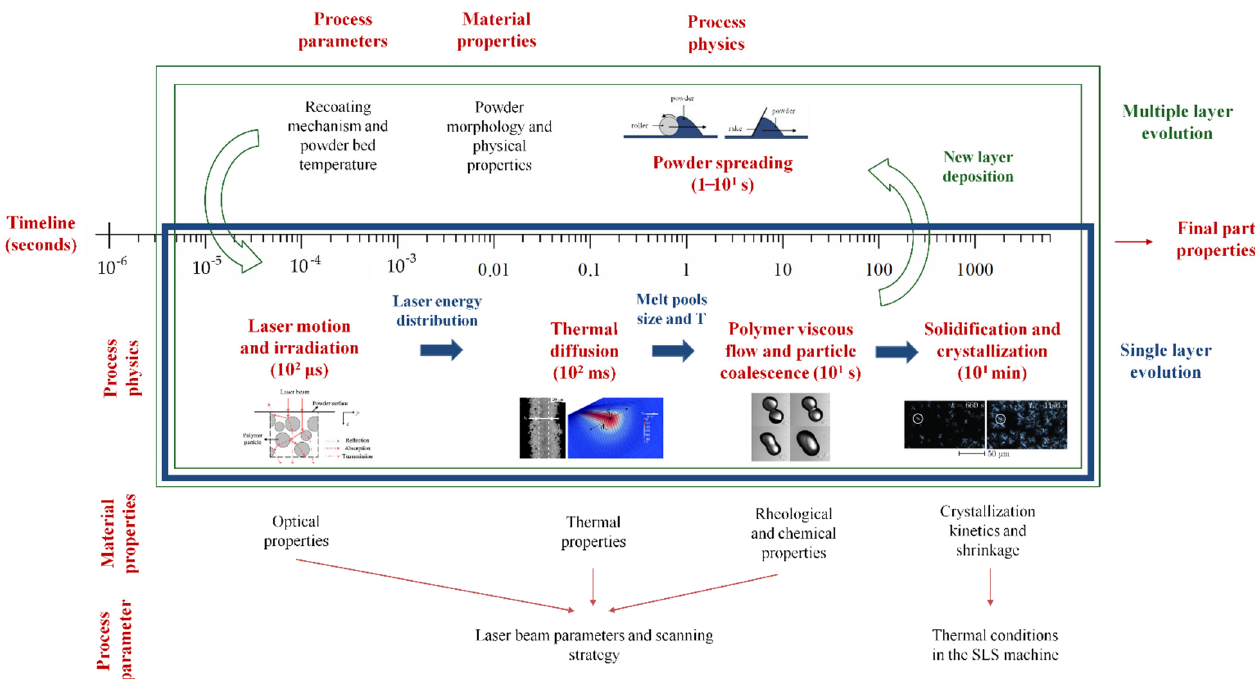
Figure 2. Timescale of the different physical phenomena involved in the SLS process, powder re- quirements for effective sintering, and relevant process parameters.